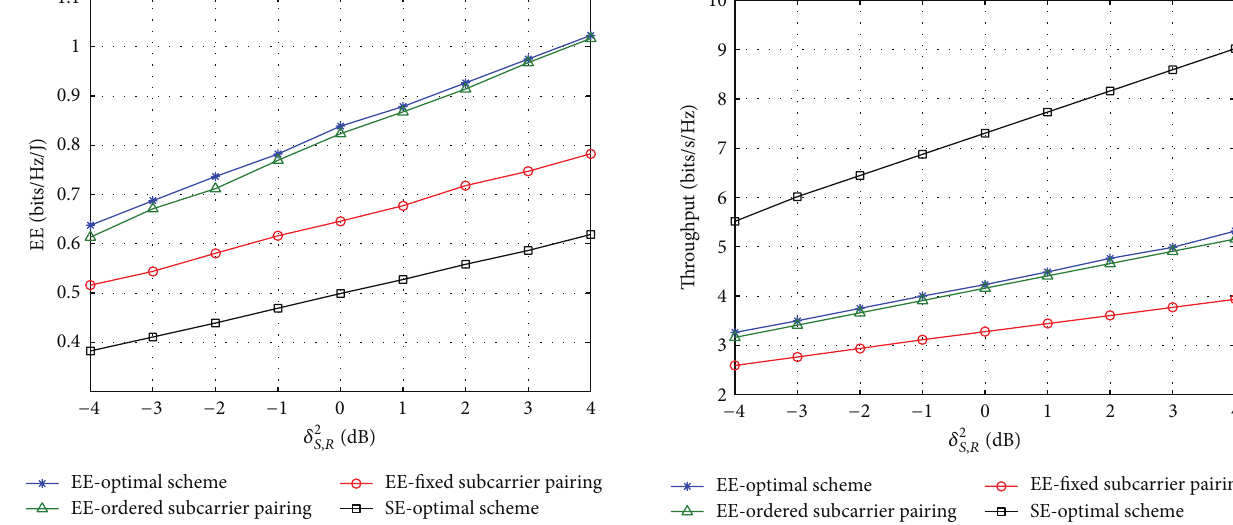
Figure 5: Throughput versus channel variance of 𝑆 → 𝑅 link with = 1 , 𝑤 = 1 𝑁 = 2 relays, and 𝑤 1 2